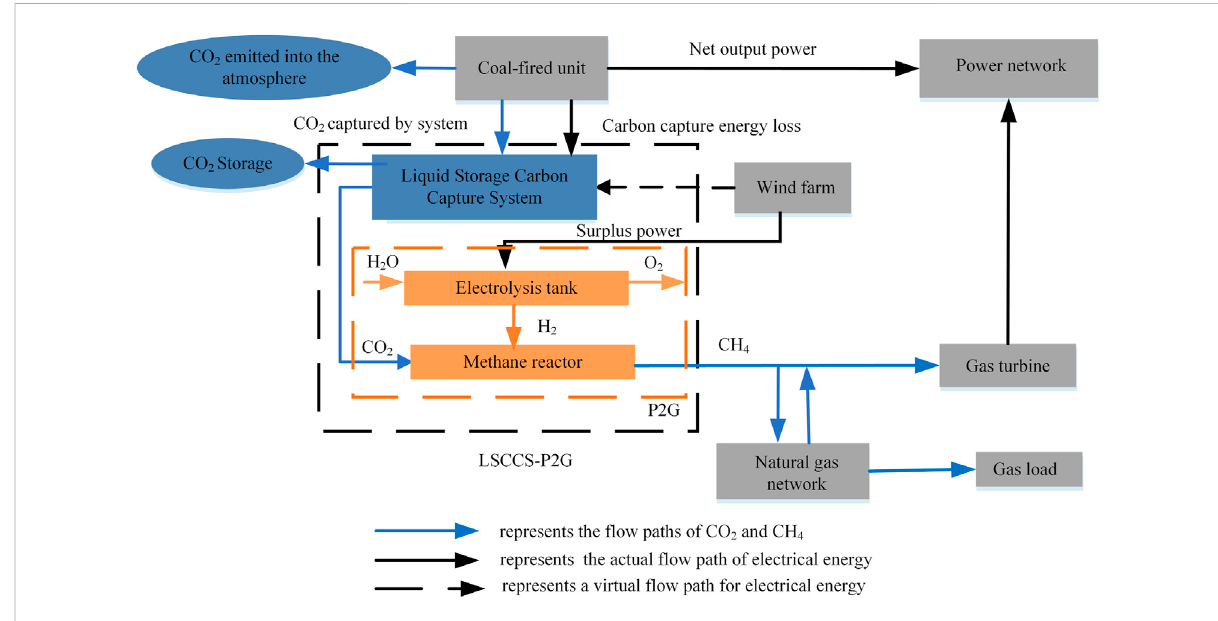
FIGURE 3 Block diagram of LSCCS-P2G combined operation